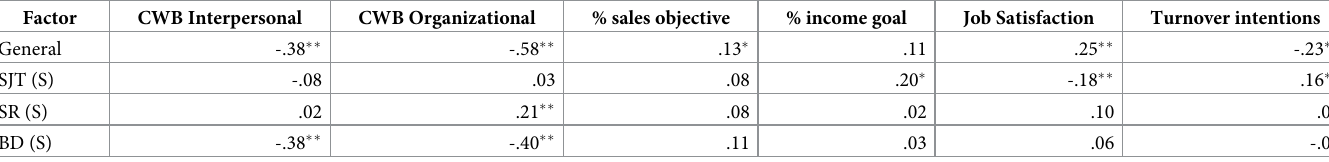
Table 5. Bi-factor model correlations with work-related